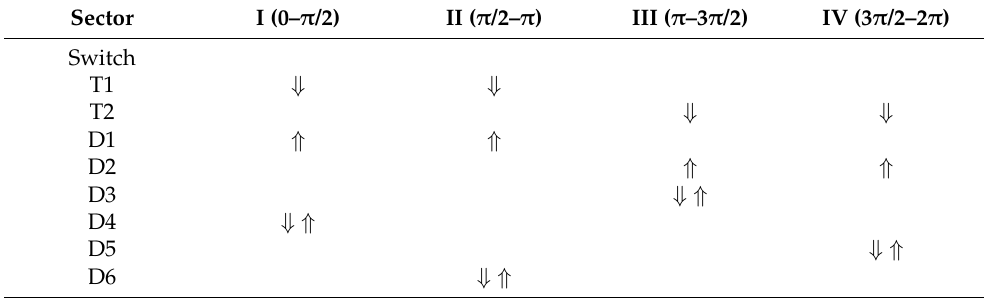
Table 1. Conduction sequences for the